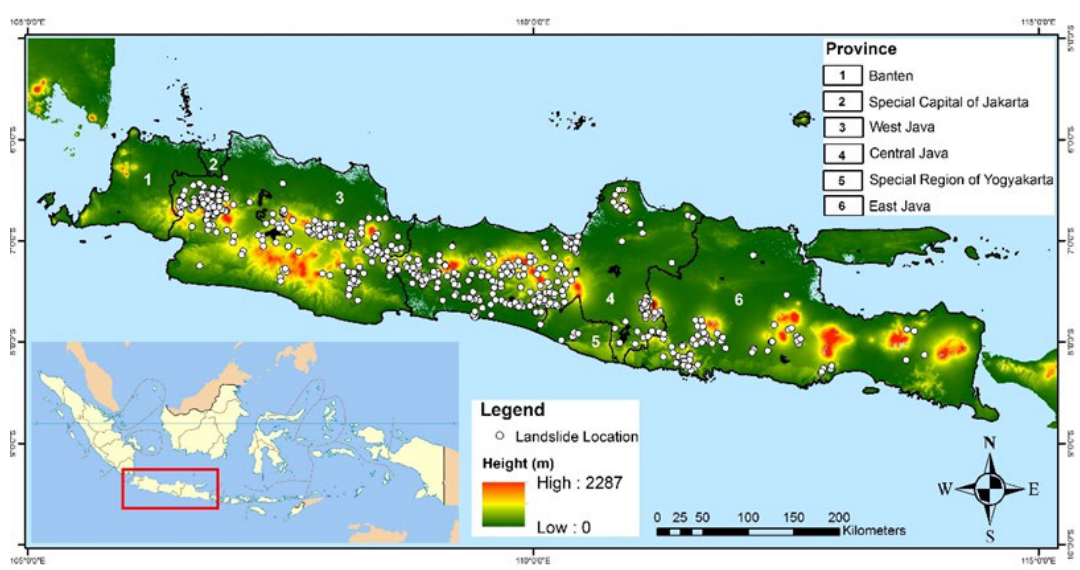
Figure 1. Digital elevation model of Java Island with the spatial distribution of landslide events from 2017 to 2020.